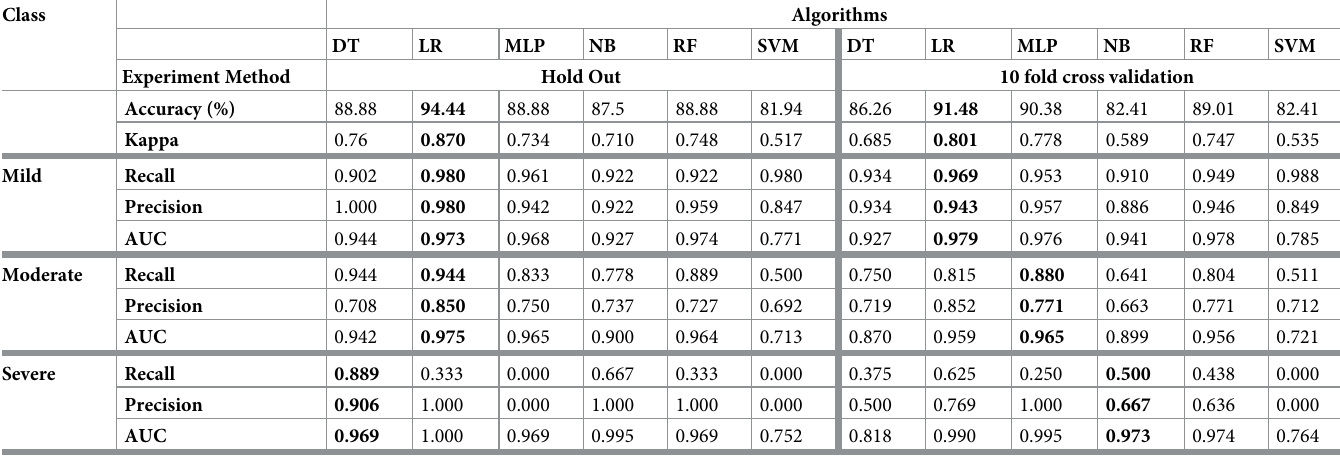
and AUC value of 99.8 percent when tested using hold-out method. Whereas in the case of10-fold cross validation Multilayer Perceptron (MLP) had given the top results with a recall value of 94.9, precision value of 91.7 and AUC value of 98.9. It can be observed that the results of the Severe class have been totally different from the earlier two classes in case of hold-out method and 10-fold cross validation methods. In the case of the hold-out, Decision Tree (DT), Logistic Regression (LR), MLP and RF have given good recall, precision and AUC values of 100 percent whereas in the case of 10-fold cross validation Logistic regression has given the high recall value of 100 percent, precision of 97.7 and AUC value of 99.8 percent. As the dataset is having disproportioned samples for the three classes, we utilized Synthetic Minority Oversampling Technique (SMOTE) to balance our dataset. Tables 7 and 8 provide the results of the experiments obtained using the SMOTE dataset. Table 7 indicates that MLP Table 8. Summary of the results obtained using the dataset4 (SMOTE and feature